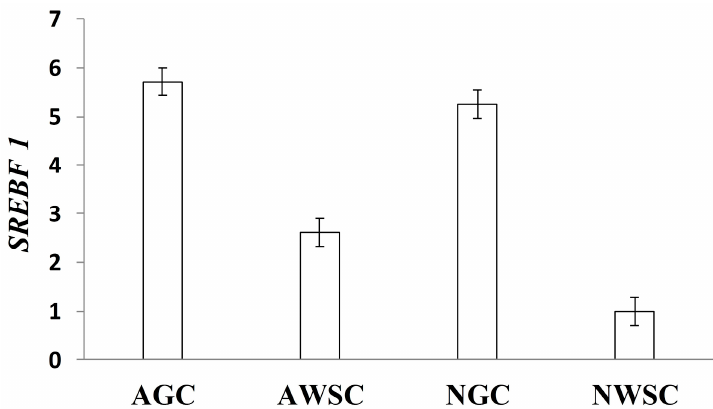
Figure 5. Relative expression of SREBF1 in the Longissimus dorsi muscle of Angus (A) and Nellore (N) bulls fed a ground corn diet (GC: 30% corn silage plus 70% concentrate based on ground corn and soybean meal) and whole shelled corn (WSC: 85% whole shelled corn plus 15% proteic-mineral supplement). Source: Teixeira [135].